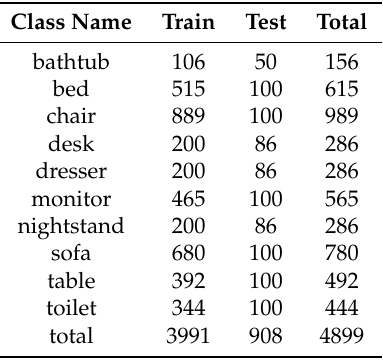
Table 1. The distribution of classes in the ModelNet10 dataset.